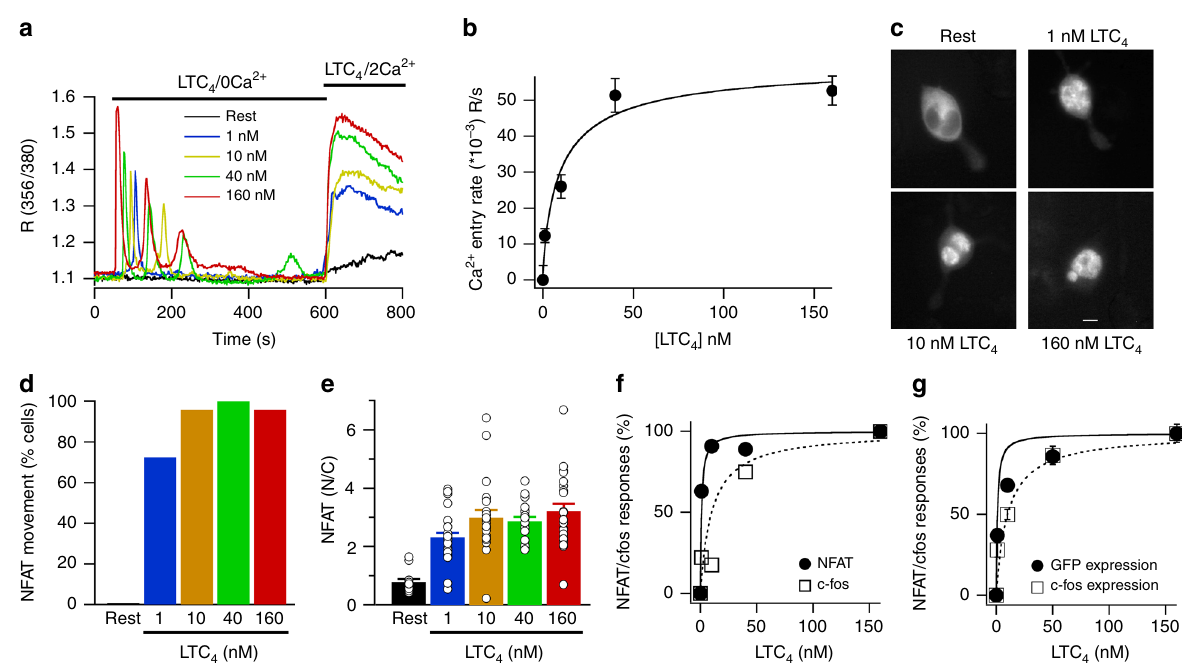
Fig. 8 Relationship between LTC 4 concentration and activation of NFAT and c-fos. a Cytosolic Ca 2 + signals to different concentrations of LTC 4 are compared. Cells were stimulated with LTC 4 in Ca 2 + -free solution and then external Ca 2 + was readmitted as shown. b Graph plots the rate of Ca 2 + entry (from panel a ) versus LTC 4 concentration. Each point is the mean of 15 – 30 cells. c Images compare distribution of NFAT1-GFP for the conditions shown. Images were taken 40 min after stimulation. Rest image was taken after 40 min in the same external solution but without stimulus. d The % of cells that showed nuclear migration of NFAT1 is compared for different agonist concentrations. e Bar chart compares NFAT1-GFP nuclear/cytosolic ratio following challenge with different LTC 4 concentrations. Each bar is 14 – 29 cells. f NFAT1 translocation and c-fos transcription (qPCR) are compared following stimulation with different LTC 4 concentrations. g Graph compares co-expression of c-fos protein and GFP under an NFAT promoter in the same cells. Cells were stimulated with different concentrations of LTC 4 for 40 min and then agonist was washed out. Cells were placed in fresh medium in the incubator for 12 h and then fi xed. C-fos expression was measured using immunocytochemistry and NFAT-reporter gene expression by GFP fl uorescence. C-fos responses re fl ect the extent of protein expression normalised to the response evoked by 160 nM LTC 4 . NFAT responses are represented by the % of GFP- positive cells, normalised to the response evoked by 160 nM LTC 4 . This parameter was used because the extent of reporter gene expression is independent of LTC 4 stimulus intensity 31 . LTC 4 EC 50 values were 1 nM for GFP expression and 9.8 nM for c-fos expression. Dose – response curves were fi tted to